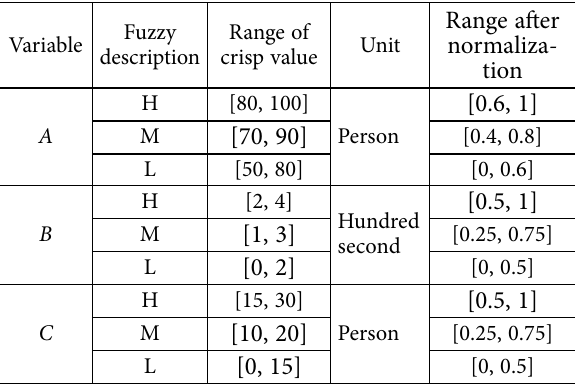
Table 3. Fuzzy classification of variables A , B , C Fuzzy Variable description